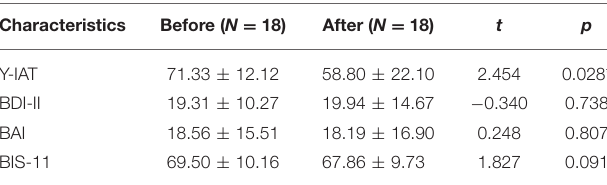
TABLE 2 | Changes in the clinical characteristics of patients with Internet gaming disorder (IGD) before and after treatment.